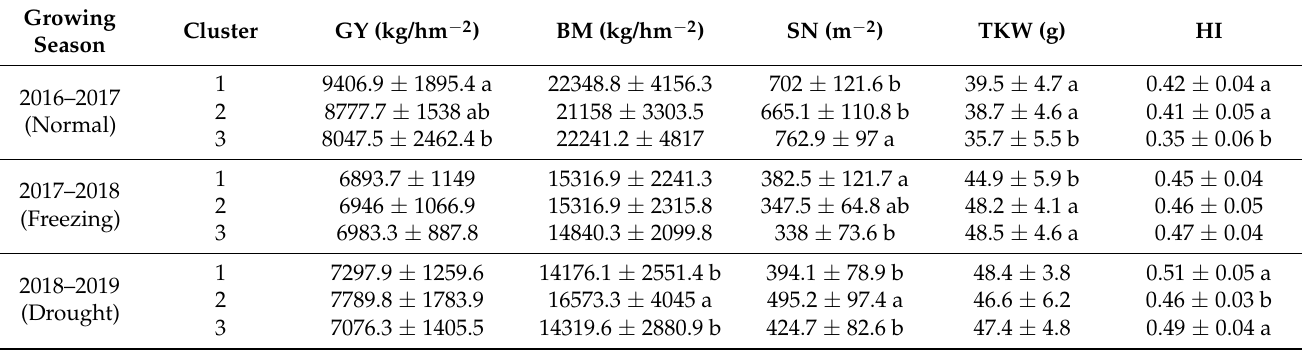
Table 5. Multiple comparisons of yield traits among the clusters of varieties based on CTDs at the three stages and structural traits for each growing